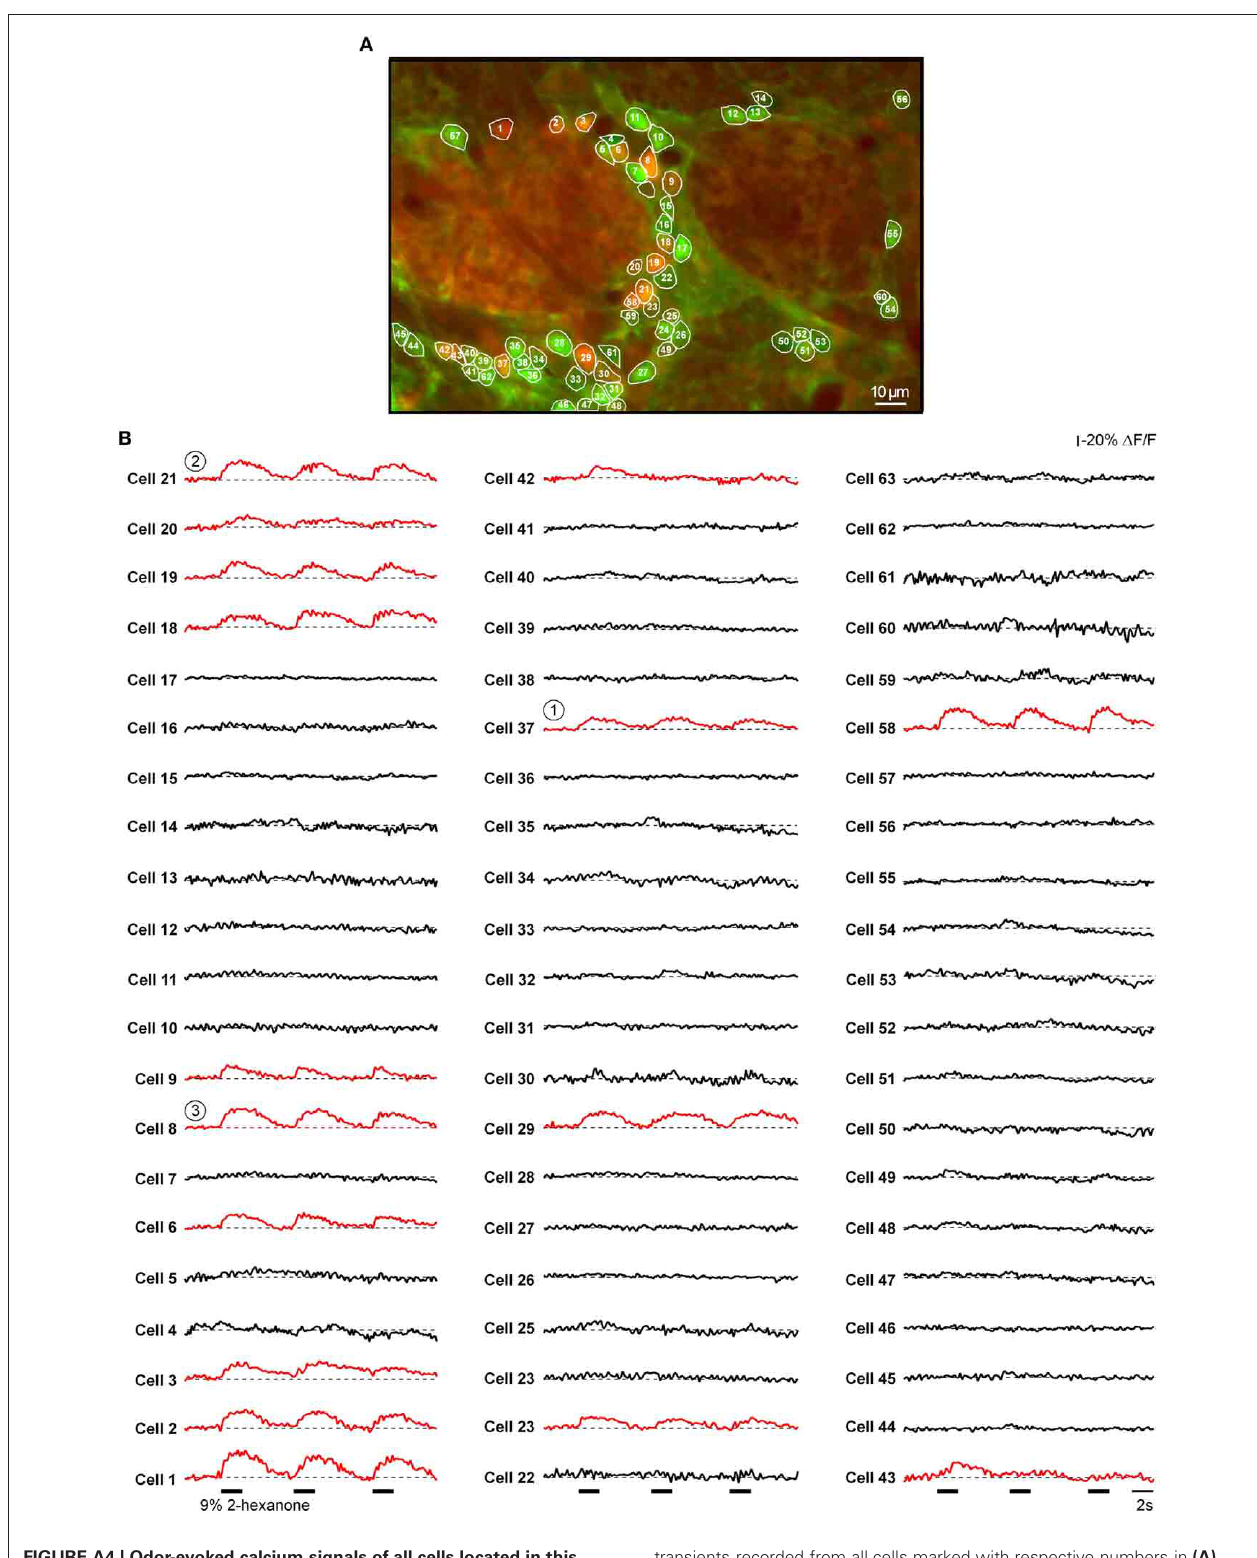
FIGURE A4 | Odor-evoked calcium signals of all cells located in this plane of focus (the same experiment as the one shown in Figure 8A). (A) The same image as in Figure 8C . The regions of interest delineate all juxtaglomerular neurons identified in this experiment. (B) Odor-evoked Ca 2 +